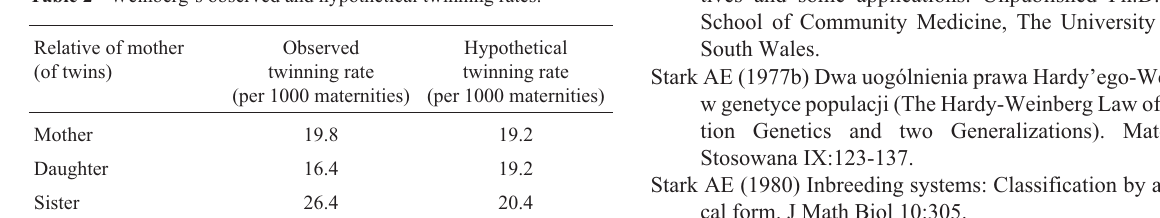
Table 2 - Weinberg’s observed and hypothetical twinning